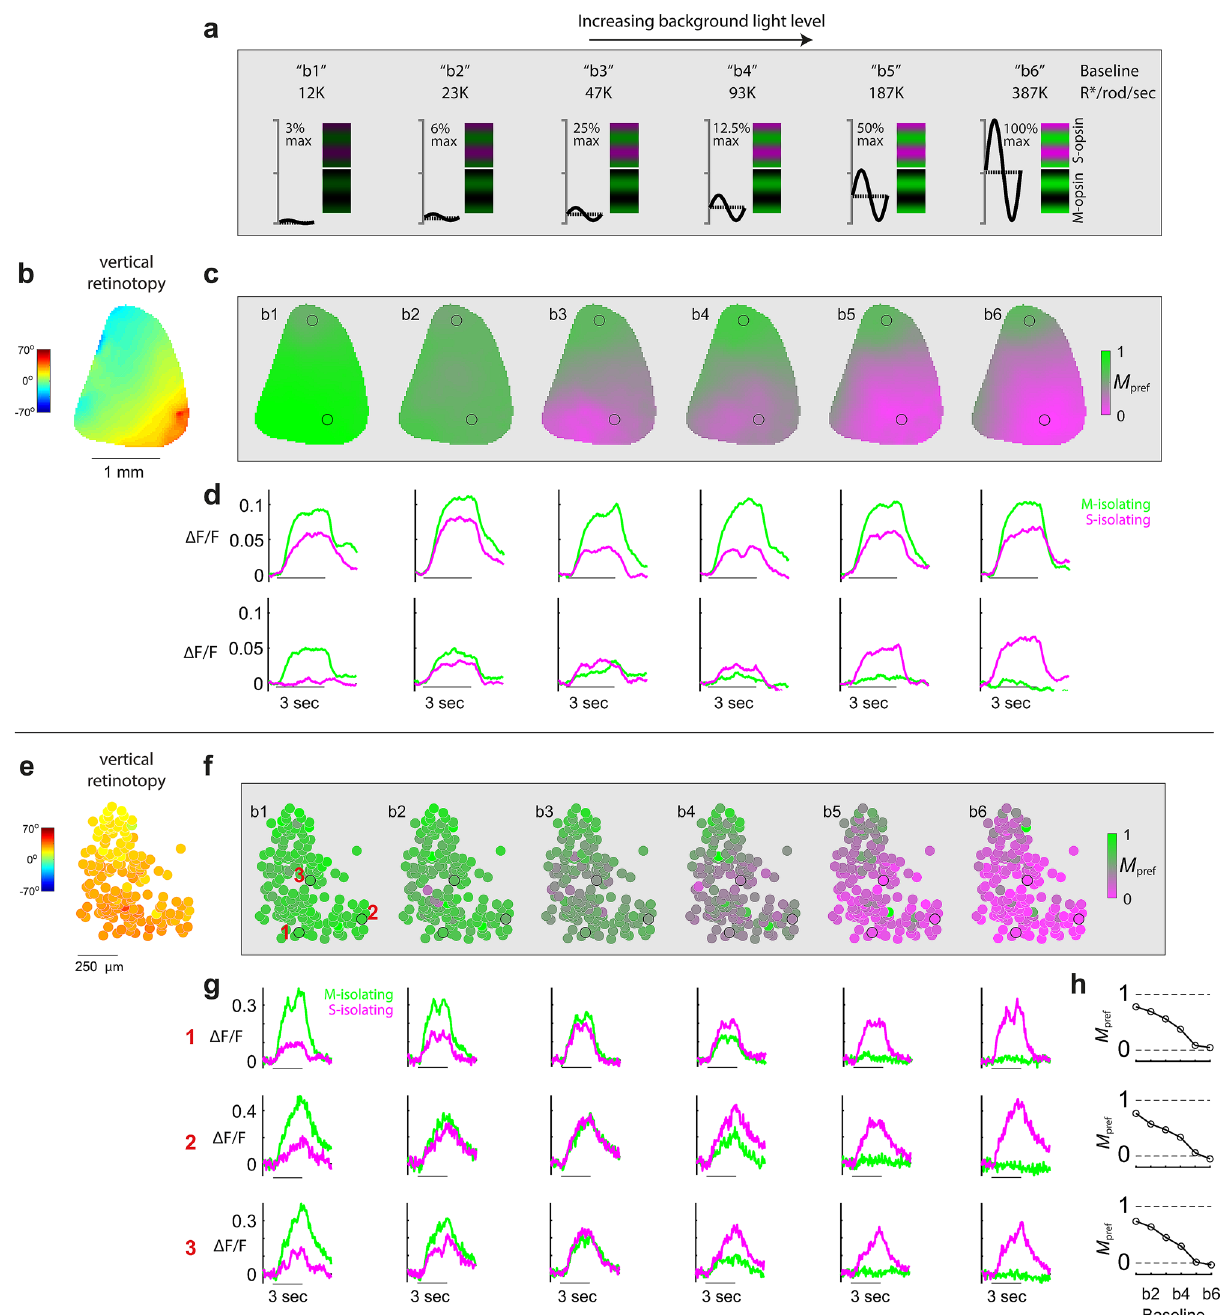
Figure 2. Revealing the cone mosaic’s M-to-S gradient in V1 via progressive rod saturation. ( a ) Illustration of the stimuli used to measure color tuning across 6 states of background light adaptation, “b1-b6”. Each subsequent adaptation levels have mean gray values that differ by a factor of 2, and constant sinewave contrast, depicted on left side of each subpanel. Prior to each level, the eye was adapted at the same gray value for 10 min. Each trial within a level block had either a S-opsin or M-opsin isolating grating, depicted on right side of each subpanel. ( b–d ) Wide- field calcium imaging. ( b ) Map of V1’s vertical retinotopy. ( c ) Maps of M pref , at each of the 6 states of light adaptation. M pref at each pixel indicates the preference for the M-opsin color axis, over the S-opsin color axis. At low light levels, M pref ~ 1 at all pixels, indicating rod input—rod inputs are uniform and have nearly identical spectral sensitivity as M-ospin. At higher light levels, rods saturate, revealing the M-to-S cone opsin gradient. ( d ) Two rows show time courses of fluorescence signal at the 2 ROI’s indicated in the map. Top circle corresponds to lower visual field; bottom circle corresponds to upper visual field. Green and violet traces are responses to M-opsin and S-opsin gratings, respectively. The line under each pair of traces indicates the stimulus duration. ( e–h ) 2-photon calcium imaging. ( e ) V1 map of vertical retinotopy, where each circle is the location of an example neuron. ( f ) Maps of M pref , at 6 states of light adaptation. ( g ) Each row of time courses is from a different neuron in the ROI (see their locations in M pref map at left). Green and violet traces are responses to M-opsin and S-opsin gratings, respectively. ( h ) Right-most column shows each example neuron’s mean M pref during stimulus presentation, as a function of light